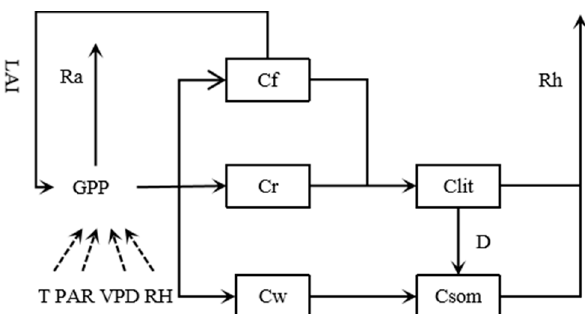
Figure 1. Schematic diagram of the structure of the Data Assimilation Linked Ecosystem Carbon (DALEC) model. Air temperature (T), photosynthetically active radiation (PAR), saturated vapor pressure difference (VPD), relative humidity (RH), leaf area index (LAI), gross primary productivity (GPP), decomposition (D), autotrophic respiration (Ra), heterotrophic respiration (Rh). C pools: foliage (Cf), wood (Cw), fine roots (Cr), litter (Clit), soil (Csom).